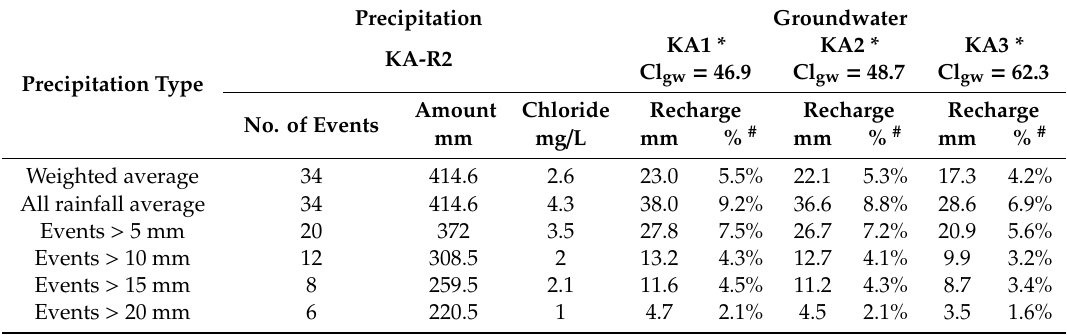
Table 4. Evaluation of which precipitation events are most likely to contribute to recharge using boreholes KA1–3 and the daily precipitation collector KA-R2 along the upper part of the Krom Antonies in the Moutonshoek valley (see Figure